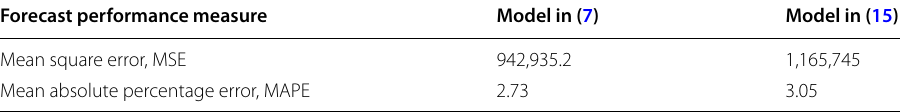
Table 4 Forecast performance measures between models (7) and (15) Forecast performance measure Model in (7) Model in (15) Mean square error, MSE Mean absolute percentage error,